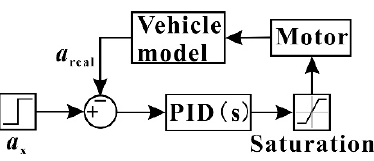
Figure 2. Brake deceleration following model. Table 1. PID parameter optimization results